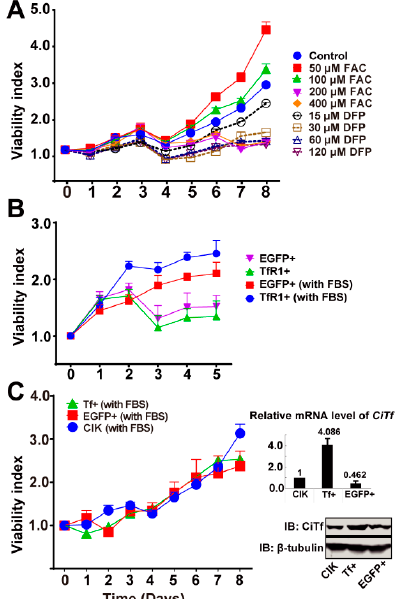
Figure 9. Both iron and CiTfR1 , but not CiTf , facilitate the growth of CIK cells. ( A ) The growth curves of CIK cells cultured in medium with FBS and different concentrations of FAC, or DFP. ( B ) The growth curves of EGFP+ and TfR1+ cells cultured in medium with FBS or without FBS. ( C ) The growth curves of EGFP+ and Tf+ cells cultured in medium with FBS. All the data in the growth curves were obtained by MTT assay. Relative CiTf mRNA levels in the three sorts of cells were detected by RT-qPCR, in which EF1 α severed as the reference gene. The protein levels were measured by WB. Data in the growth curve and overexpression verification represent mean ± SD of three independent experiments.